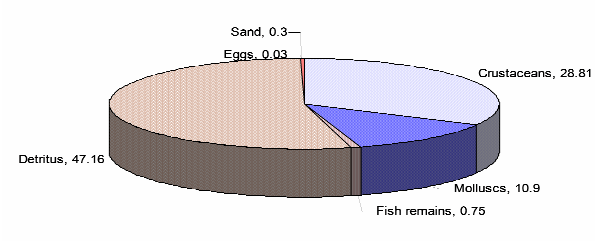
Fig. 2. Diet composition (Index of preponderance) of females of S.